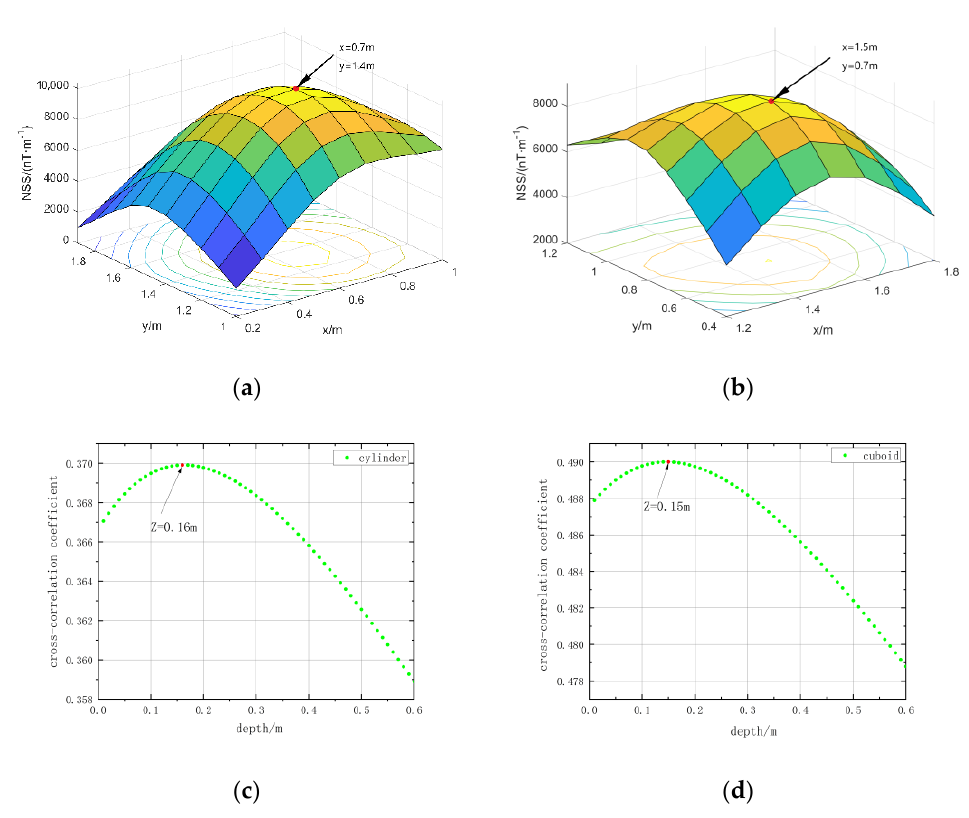
Figure 15. Estimated results of the center position of the measured magnetic object: ( a ) Horizontal position of cylinder; ( b ) horizontal position of cuboid; ( c ) cylinder depth; ( d ) cuboid depth. Table 5. The center position estimation result and absolute error. CYLINDER cuboid Cylinder